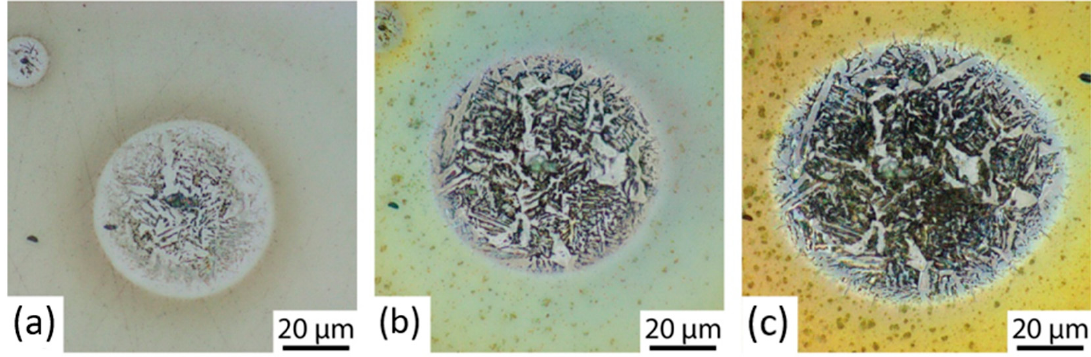
Figure 11. Corrosion pit, Mn-Si-HT steel: ( a ) 1 min; ( b ) 5 min; ( c ) 20 min immersion (demineralized water).